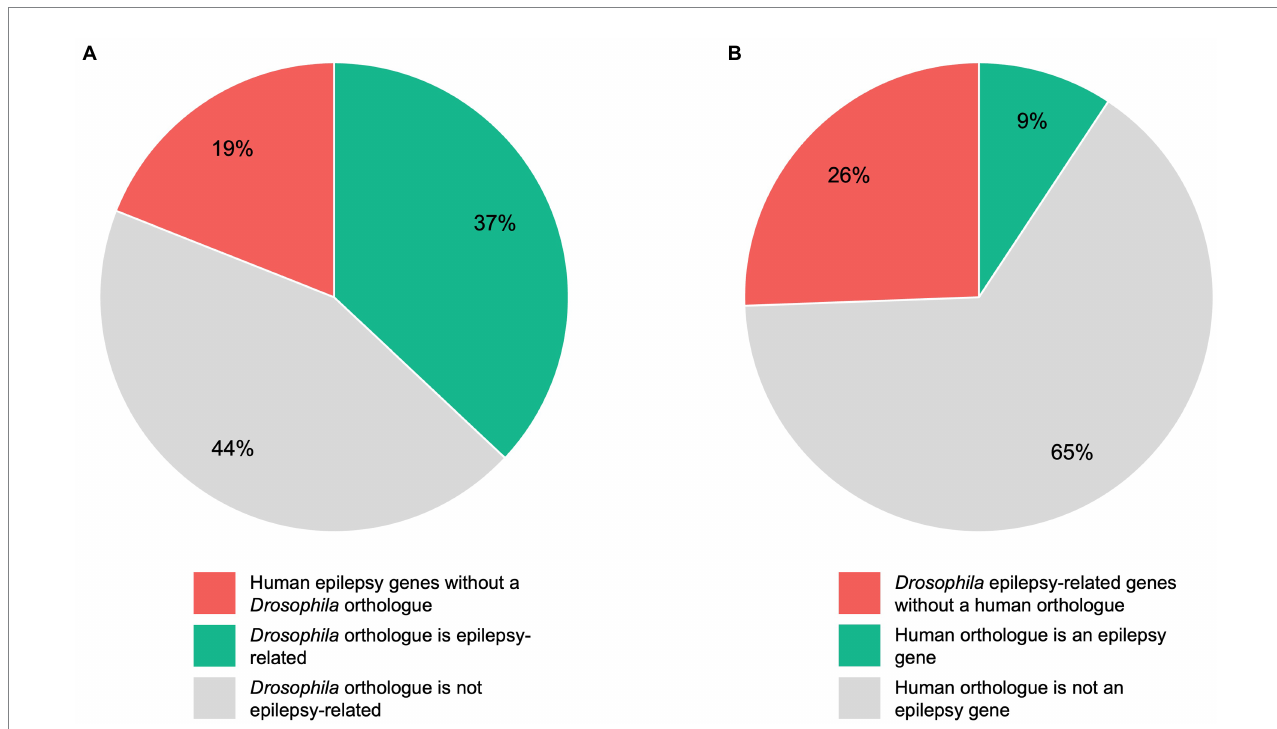
FIGURE 2 Comparison of human and Drosophila epilepsy genes. A total of 145 human genes were defined as “epilepsy genes”, whereas 344 Drosophila genes were defined as “epilepsy-related” genes as described under “Determination of orthologous genes”. Pie chart (A) shows the 145 human epilepsy genes divided into those genes without a Drosophila orthologue, genes whose Drosophila orthologue is epilepsy-related, and genes whose Drosophila orthologue is not epilepsy-related. Pie chart (B) shows the 344 epilepsy-related Drosophila genes divided into those genes without a human orthologue, genes whose human orthologue is an epilepsy gene, and genes whose human orthologue is not an epilepsy